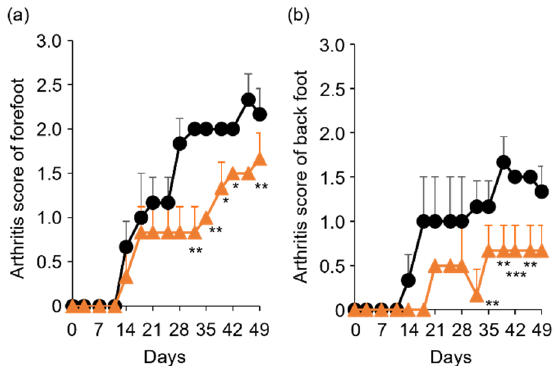
Figure 6. Comparison of arthritis score between control and TP-administered mice. ( a , b ) PBS ( − ) (black lines) and TP dissolved in PBS ( − ) (orange lines) were intraperitoneally administered into mice three times a week from 7 days after laminarin injection. Arthritis scores of forefoot ( a ) and back foot ( b ) were evaluated as described in materials and methods section. N = 3, Bars represent SD. * p < 0.05, ** p < 0.01 and *** p < 0.001.